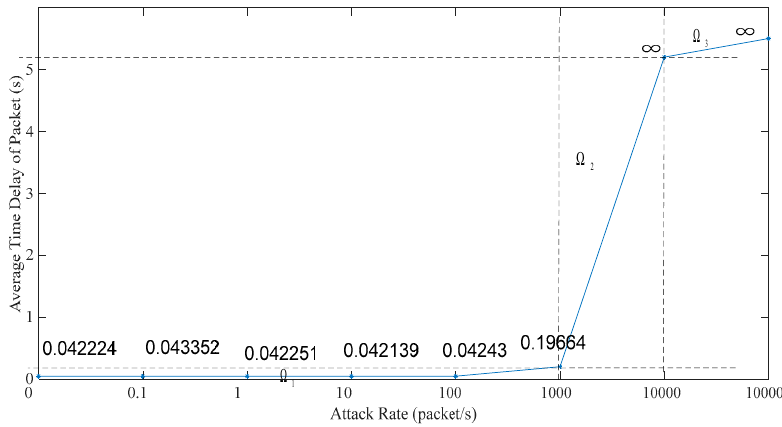
Sensors 2019 , 19 , x Figure 13. Min transmission time delay under different DoS attack rates. Figure 13. Min transmission time delay under different DoS attack rates.